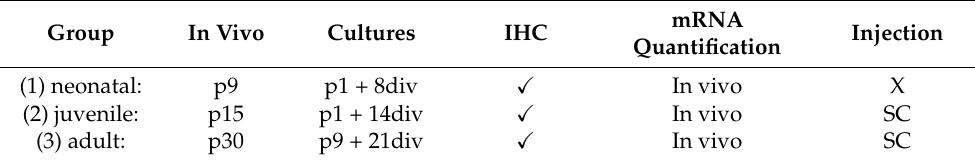
Table 1. Overview of age groups and experiments. Listed are the developmental stages of (PC used in this research work, including the corresponding slice culture incubation times and the applied experimental protocols. IHC = immunohistochemistry; (cid:88) = slice cultures and in vivo; SC = slice cultures only; X = not